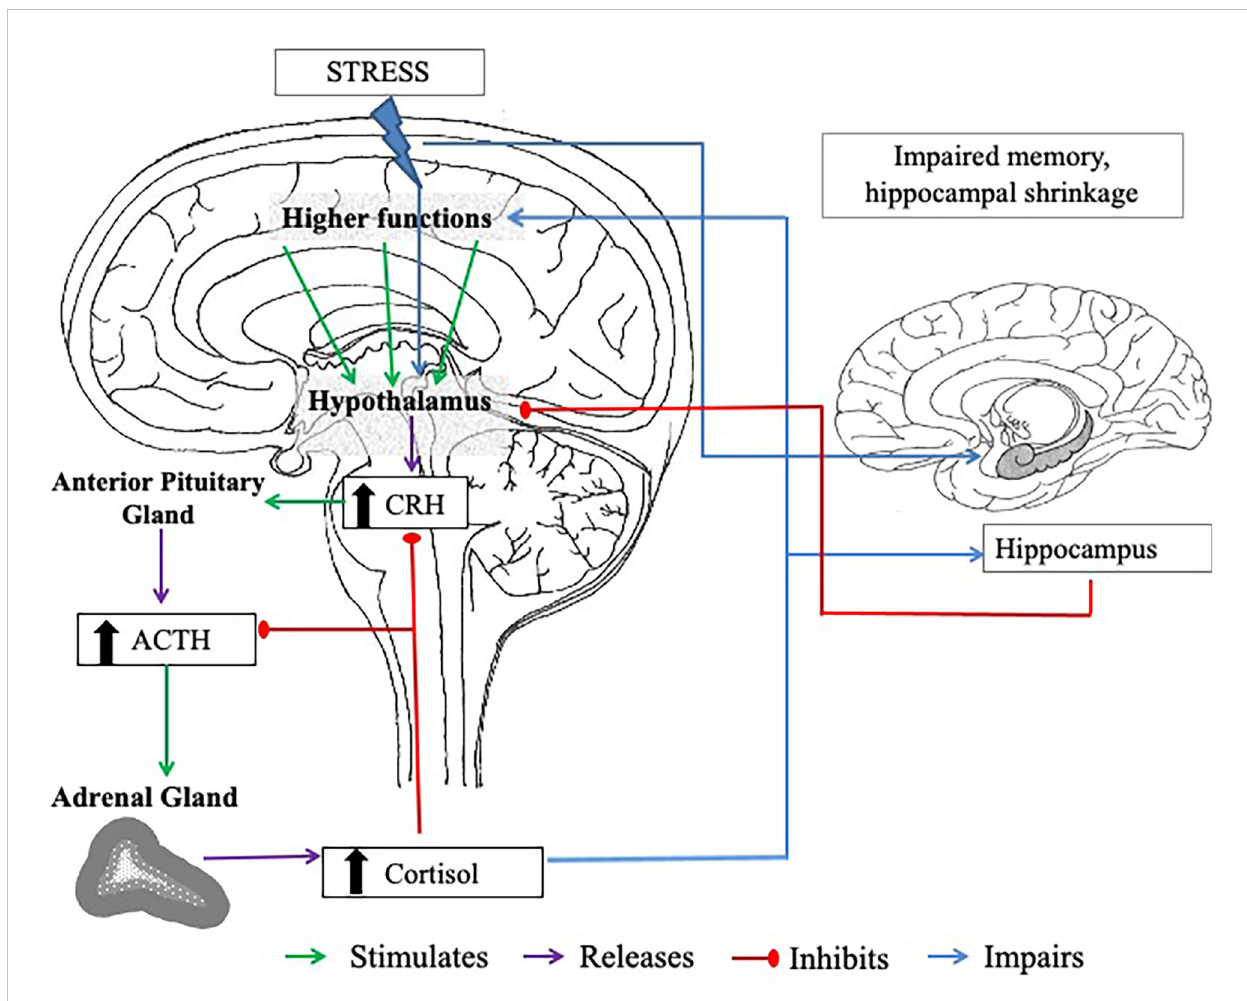
FIGURE 1 The negative feedback loop of the HPA axis. CRH = corticotropin-releasing hormone. ACTH = adrenocorticotropic hormone. The body experiences a stressor; this triggers the hypothalamus to release CRH, which stimulates the anterior lobe of the pituitary gland to release ACTH. The adrenal cortex of the adrenal glands responds to stimulation by the ACTH and produces cortisol. High plasma cortisol stimulates the hippocampus (a brain region involved in memory processes, that has an abundance of corticosteroid receptor sites), which also has inhibitory control over the HPA axis to prevent excess cortisol release. When stress is chronic, high levels of circulating cortisol can cause long-term damage to the hippocampus, including hippocampal shrinkage, which can impair the actions of the negative feedback loop. Cortisol also has a negative feedback on the hypothalamus and the pituitary gland, inhibiting CRH and ACTH